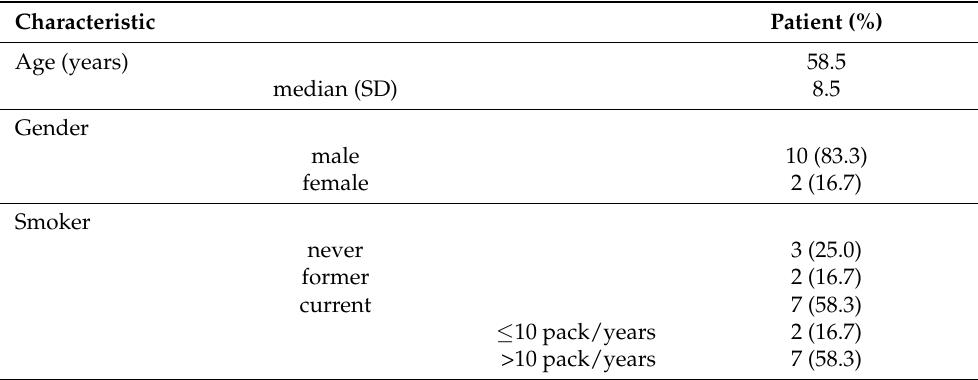
Table 1. Baseline